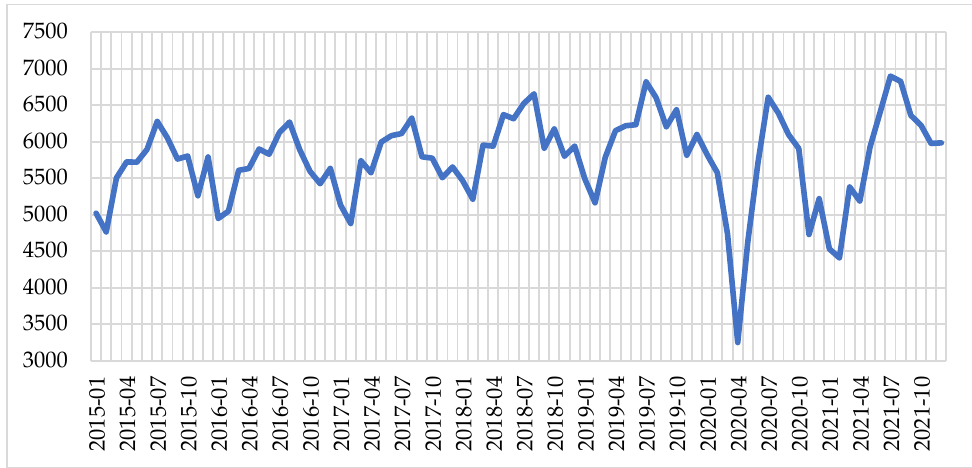
Figure 8. Changes in the volume of motor gasoline supplies to EU countries (in thousand tonnes). Source: own elaboration.